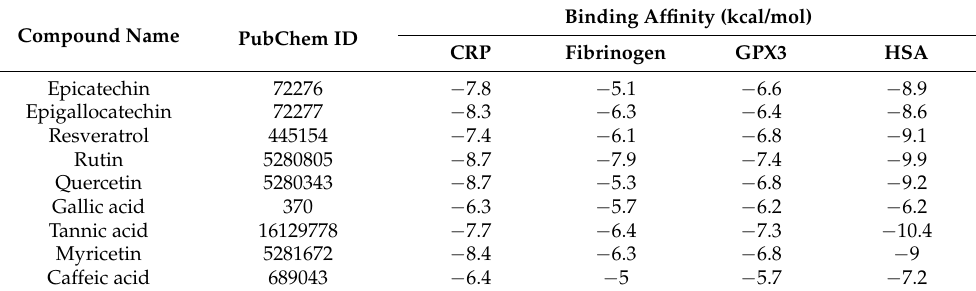
Table 3. Binding affinity score of wine components docked with serum